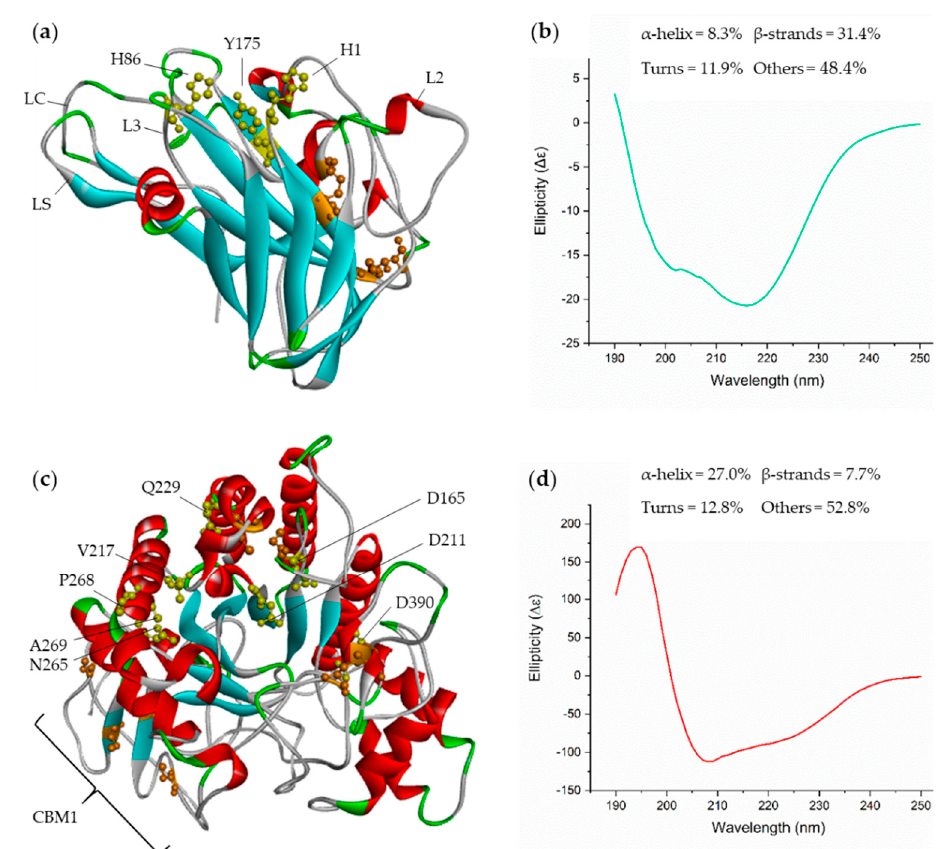
Figure 2. Ribbon representation of the enzymes Af AA9_B ( a ) and Af Cel6A ( c ) and their main conserved residues and structures. Active site residues are represented in yellow, and disulfide bonds are represented in orange. Af AA9_B loops are represented by LC (C-terminus), LS (short), L3, and L2. CBM1 residues are indicated by a brace in Af Cel6A. Circular dichroism spectra obtained from 190 to 250 nm (UV-distant) for Af AA9_B with Cu(II) ( b ) and Af Cel6A ( d ) at 25 °C. Both enzymes were in 20 mM sodium phosphate buffer (pH = 7.4), and the spectra were read by using a quartz cuvette with an optical path of 0.1 cm. The mean spectra for each sample were normalized by subtracting the buffer spectrum.